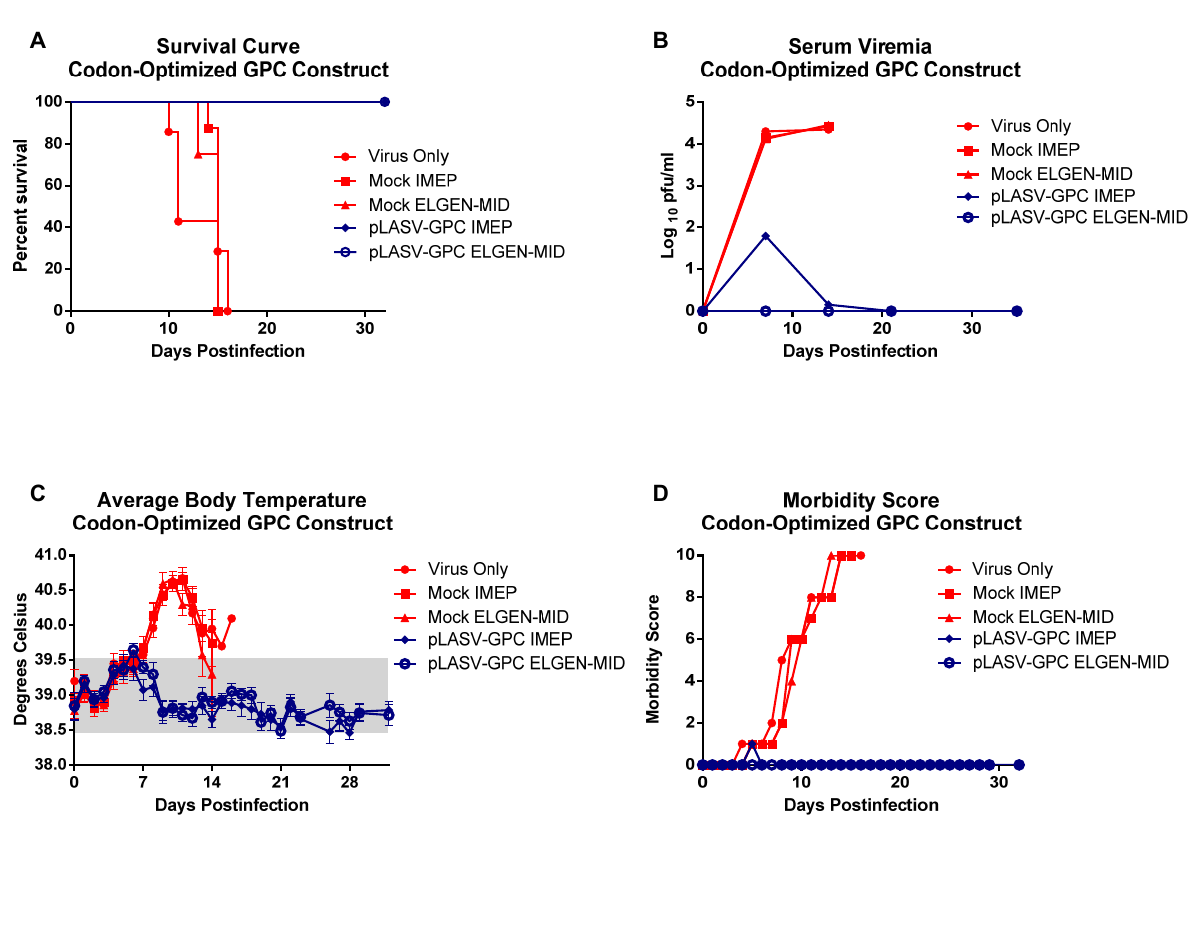
Figure 3. Outcomes for dermal versus muscle electroporation using the codon-optimized LASV DNA construct. ( A ) Survival curve; ( B ) Serum viremia as measured by plaque assay; ( C ) Average body temperature changes as a function of time postinfection, and ( D ) Morbidity score based on observed disease signs. The grey bar indicates the normal body temperature range for guinea